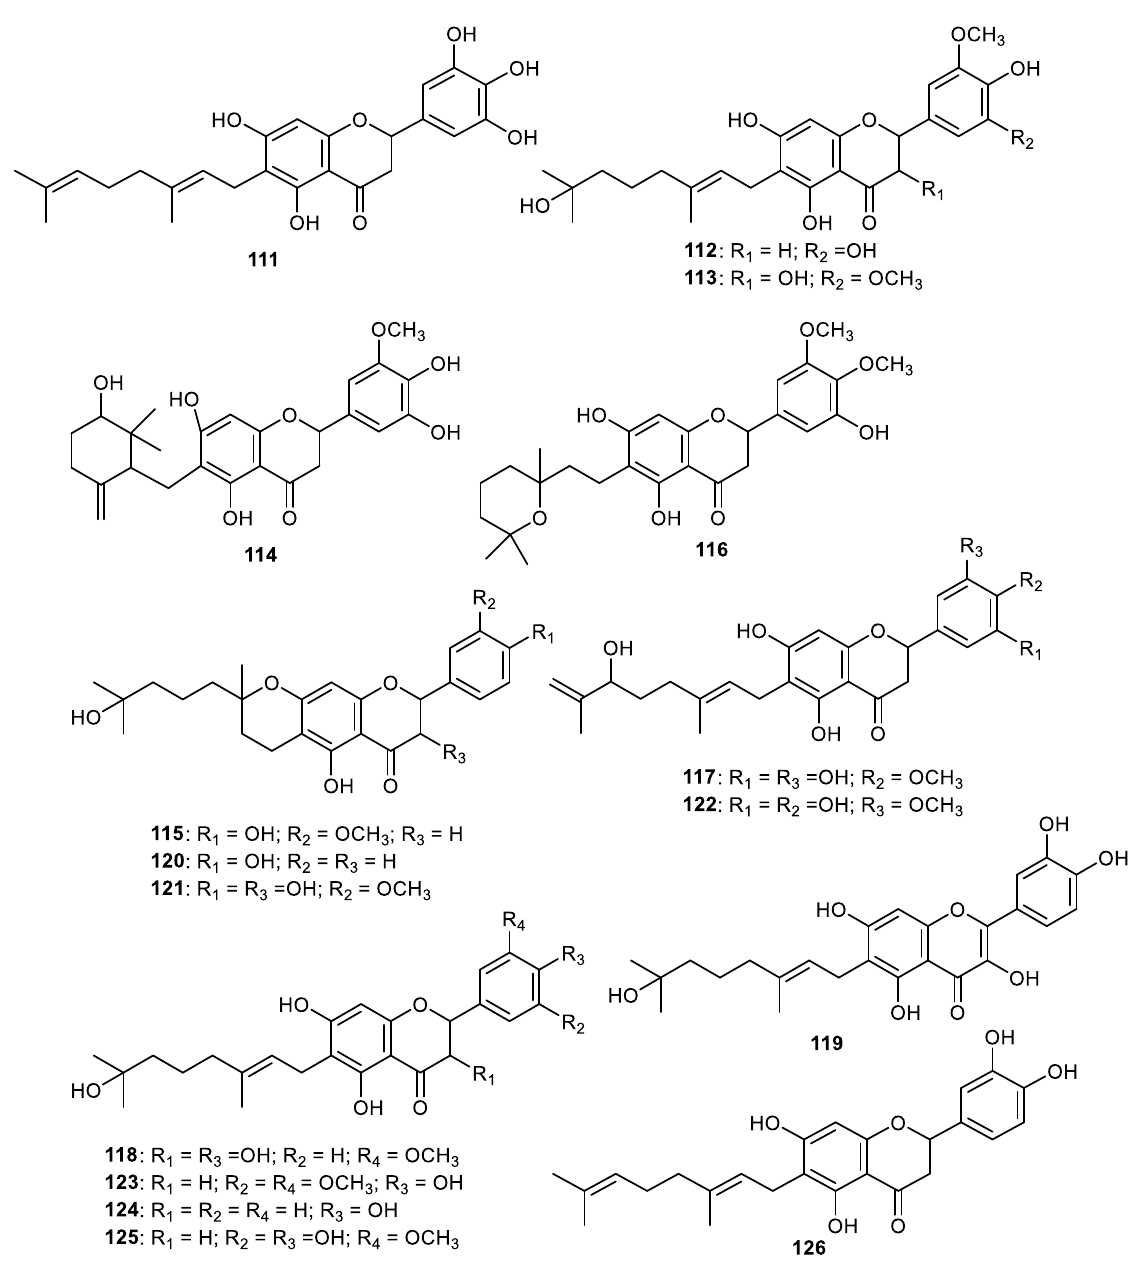
Figure 14. Structures of flavonoids 111 – 126 .